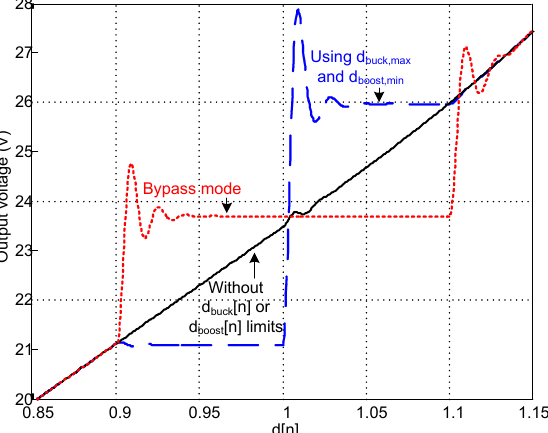
Figure 15. Simulated output voltage considering d buck,max = 1 and d boost,min = 0 (continuous line). Simulated output voltage for d buck,max = 0.90 and d boost,min = 0.10, using two simple solutions to determine d buck [n] and d boost [n]. Solutions presented in Section 2.1 (dashed and dotted lines).